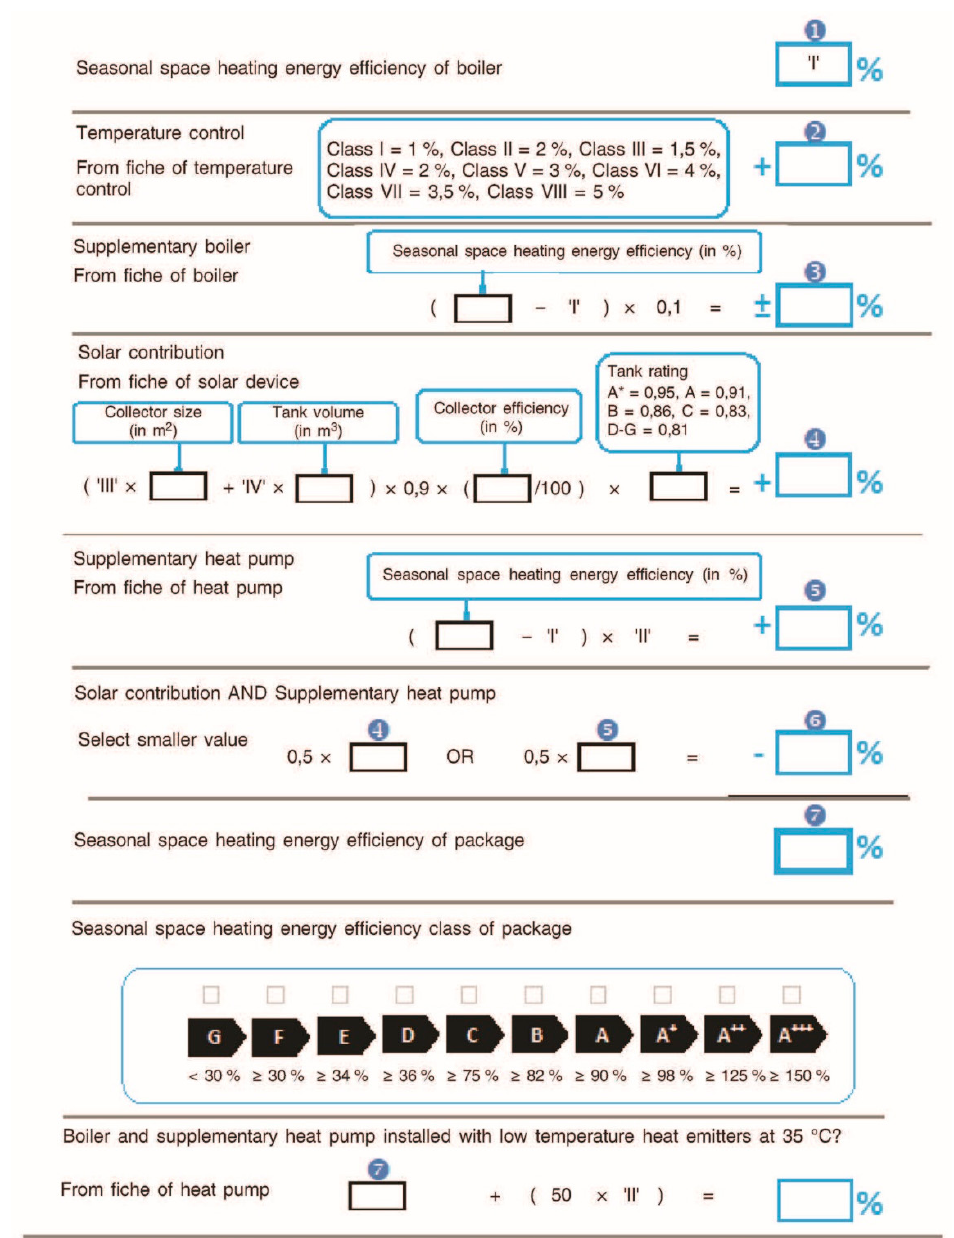
Figure 4. Illustration of Figure 1 (space and combination heaters) of Regulation 811/2013 ( Annex 4 ) [10] © European Union, http://eur-lex.europa.eu/, 1998–2017.